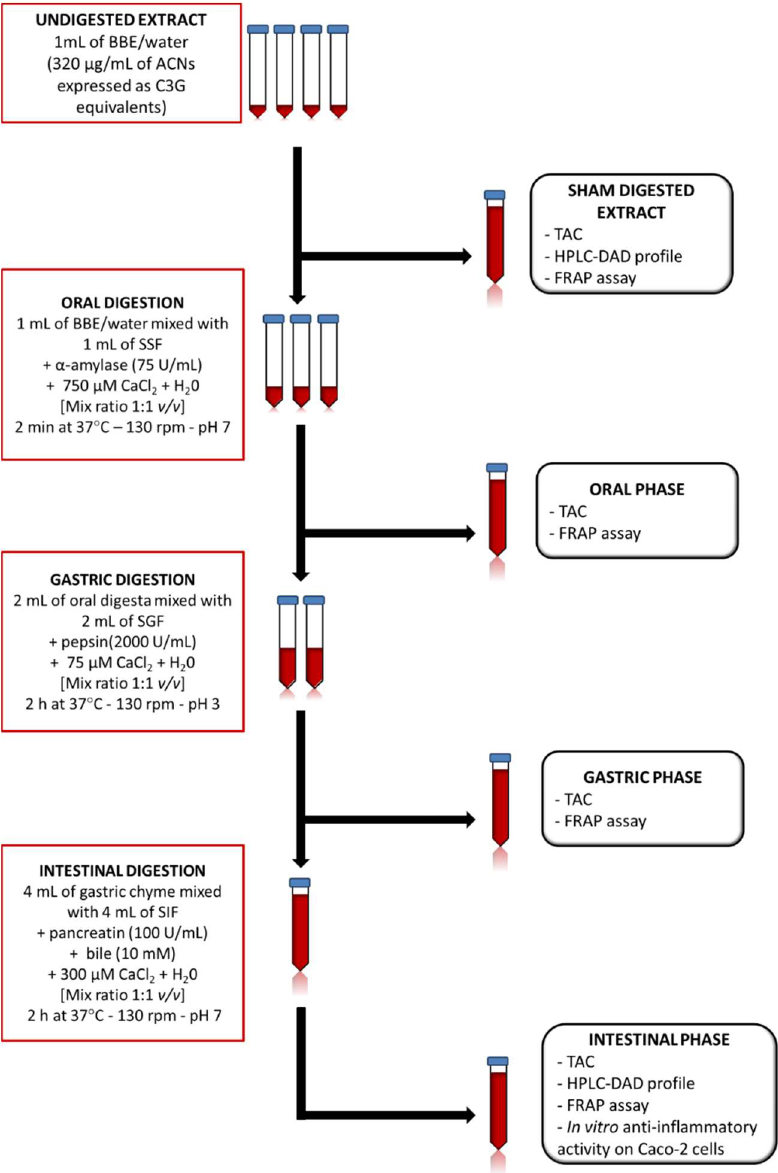
Figure 8. Schematic workflow of the in vitro simulated gastrointestinal digestion method.